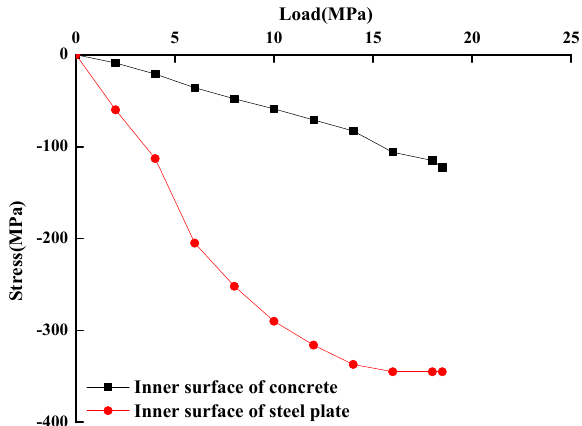
Figure 9. Load–hoop stress curve of specimen ZJ1. Figure 10. Load–hoop stress curve of specimen ZJ4.